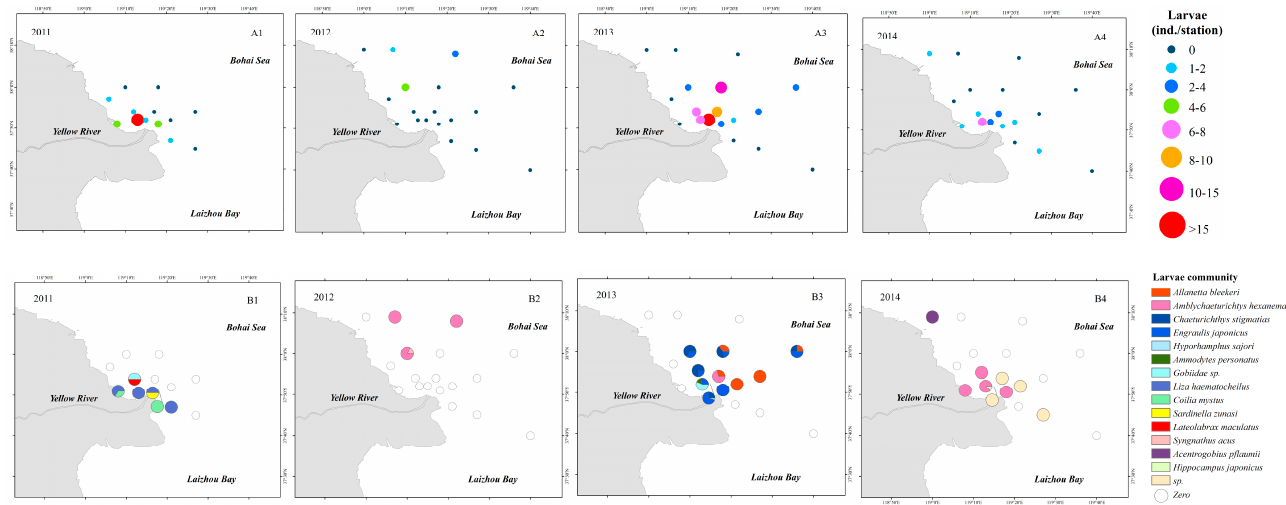
Figure 5. Spatial distribution of larvae collected in this study. ( A1 – A4 ), Larval abundances. ( B1 – B4 ), Larval communities. ( B1 – B4 ), Larval